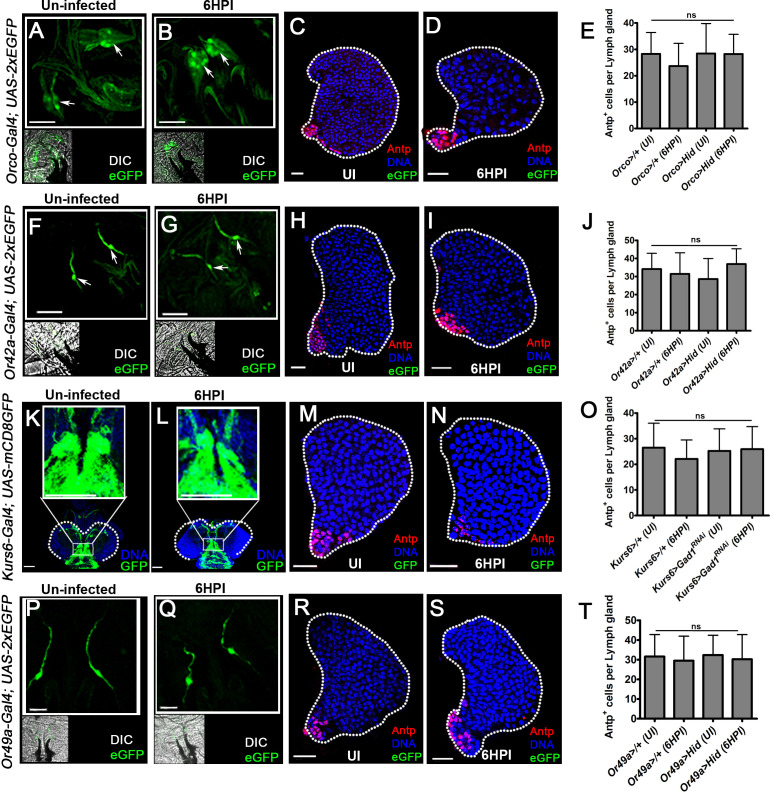
Expression profile of the neuronal driver lines.UI is uninfected, HPI indicates hours post wasp-infection. Scale bars in panels (A, B, F, G, K, L, P, Q = 50 µm and C, D, H, I, M, N, R) and S = 20 µm. In panels (E, J, O, and T), mean ± standard deviation (mean ± SD) is shown and statistical analysis is unpaired t-test, two-tailed. For lymph glands ‘n’ represents lymph gland lobes analyzed. ns means nonsignificant. For better representation of the lymph gland primary lobes, the images shown, have been edited for removal of adjacent tissues (like dorsal vessel and ring gland). (A, B) Expression of Orco-Gal4 (green, Orco-Gal4; UAS-2xEGFP) in (A) uninfected and (B) infected (6HPI) conditions remains unchanged. Arrows indicate Dorsal organ ganglion. The small insets are DIC acquisition of the same images shown in (a and b). (C, D) No expression of Orco-Gal4 (green, Orco-Gal4; UAS-2xEGFP) is detected in cells of the lymph gland or in the posterior signaling center PSC (Antp, red) in (C) uninfected and (D) infected (6HPI) condition. (E) Quantification of Antp + cells per lymph gland in Orco-Gal4; UAS-2xEGFP, uninfected (n = 11), Orco-Gal4; UAS-2xEGFP, 6HPI (n = 12, ns compared to Orco-Gal4; UAS-2xEGFP, uninfected), Orco-Gal4; UAS-Hid, uninfected (n = 12, ns compared Orco-Gal4; UAS-2xEGFP, uninfected), and Orco-Gal4; UAS-Hid, 6HPI (n = 12, ns compared to Orco-Gal4; UAS-2xEGFP, 6HPI) showed no change in their numbers. (F, G) Expression of Or42a-Gal4 (green, Or42a-Gal4; UAS-2xEGFP) in (F) uninfected and (G) infected condition (6HPI) remains unchanged. Arrows indicate Dorsal organ ganglion. The small insets are DIC acquisition of the same images shown in (F and G). (H, I) No expression of Or42a-Gal4 (green, Or42a-Gal4; UAS-2xEGFP) is detected in cells of the lymph gland or in the PSC (Antp, red) in (H) uninfected and (I) infected (6HPI) conditions. (J) Quantification of Antp + cells per lymph gland in Or42a-Gal4; UAS-2xEGFP, uninfected (n = 16), and Or42a-Gal4; UAS-2xEGFP, 6HPI (n = 12, ns compared to Or42a-Gal4; UAS-2xEGFP, uninfected), Or42a-Gal4; UAS-Hid, uninfected (n = 10, ns compared to Or42a-Gal4; UAS-2xEGFP, uninfected), and Or42a-Gal4; UAS-Hid, 6HPI (n = 8, ns, compared to Or42a-Gal4; UAS-2xEGFP, 6HPI) showed no change in their numbers. (K, L) Expression of Kurs6-Gal4 (green, Kurs6-Gal4; UAS-mCD8GFP) in the larval brain (indicated by while dotted lines, and zoomed in image in the white box for better clarity) shows no change in (K) uninfected and (L) infected conditions (6HPI). (M, N) No expression of Kurs6-Gal4 (green, Kurs6-Gal4; UAS-mCD8GFP) is seen in the lymph gland blood cells and the PSC (Antp, red), in (M) uninfected and (N) infected (6HPI) condition. (O) Quantification of Antp + cells per lymph gland in Kurs6-Gal4; UAS-mCD8GFP, uninfected, (n = 18), Kurs6-Gal4; UAS-mCD8GFP, 6HPI (n = 10, ns compared to Kurs6-Gal4; UAS-mCD8GFP, uninfected), Kurs6-Gal4; UAS-mCD8GFP; UAS-Gad1RNAi, uninfected (n = 18, ns compared to Kurs6-Gal4; UAS-mCD8GFP, uninfected) and Kurs6-Gal4; UAS-mCD8GFP; UAS-Gad1RNAi, 6HPI (n = 23, ns, compared to Kurs6-Gal4; UAS-mCD8GFP, 6HPI) showed no change in their numbers. (P, Q) Expression of Or49a-Gal4 (green, Or49a-Gal4; UAS-2xEGFP) in (P) uninfected and (Q) infected condition (6HPI) remains unchanged. Arrows indicate Dorsal organ ganglion. The small insets are DIC acquisition of the same images shown in (P and Q). (R, S) No expression of Or49a-Gal4 (green, Or49a-Gal4; UAS-2xEGFP) is seen in the lymph gland blood cells and the PSC (Antp, red), in (r) uninfected and (s) infected (6HPI) conditions. (T) Quantification of Antp + cells per lymph gland in Or49a-Gal4; UAS-2xEGFP, uninfected, (n = 10), and Or49a-Gal4; UAS-2xEGFP, 6HPI (n = 8, ns compared to Or49a-Gal4; UAS-2xEGFP, uninfected), Or49a-Gal4; UAS-Hid, uninfected (n = 11, ns compared to Or49a-Gal4; UAS-2xEGFP, uninfected) and 6HPI (n = 9, ns, compared to Or49a-Gal4; UAS-2xEGFP, 6HPI) showed no change in their numbers.Figure 1—figure supplement 2—source data 1.Contains numerical data plotted in Figure 1—figure supplement 2E,J,O and T.